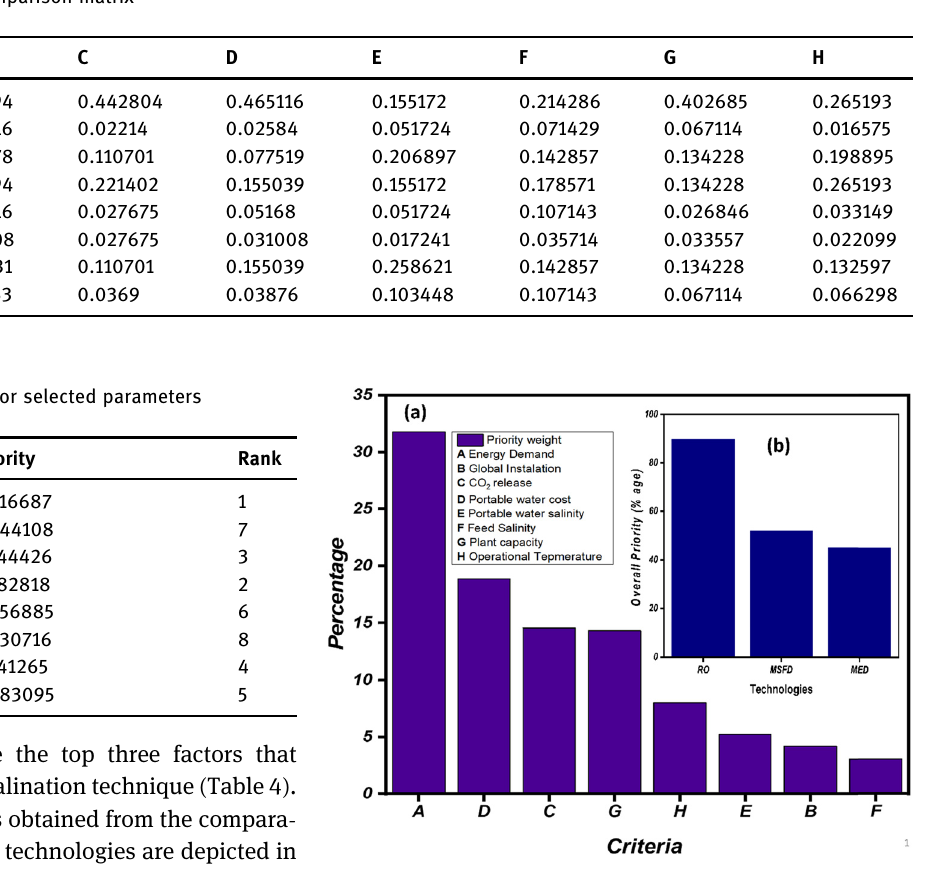
Table 3: Normalized pairwise comparison matrix